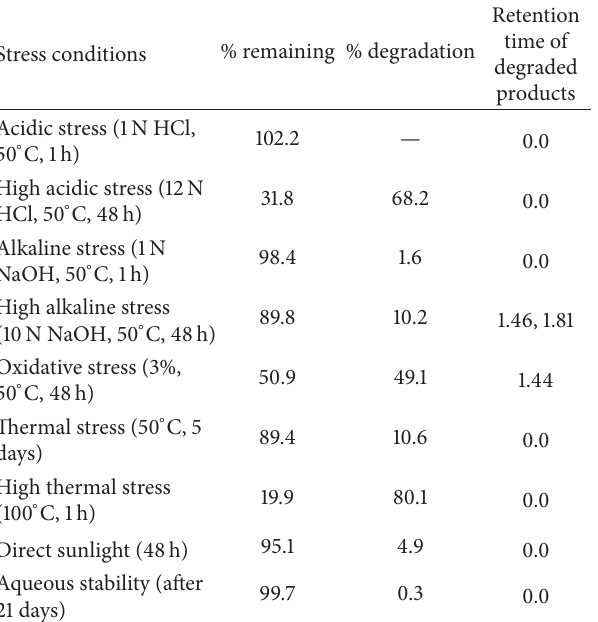
Table 2: Forced degradations